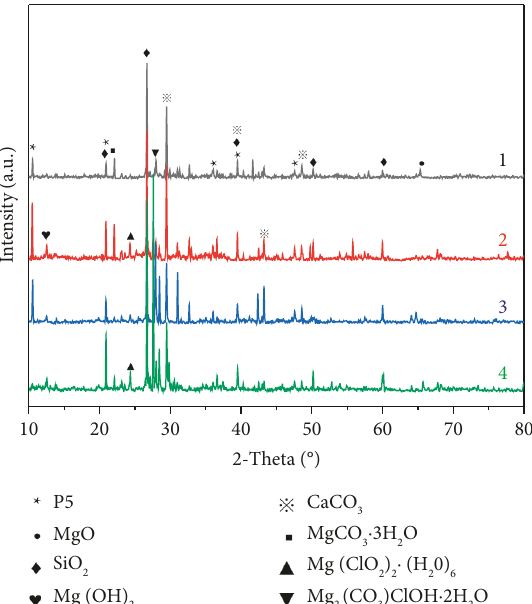
Figure 14: XRD analysis.